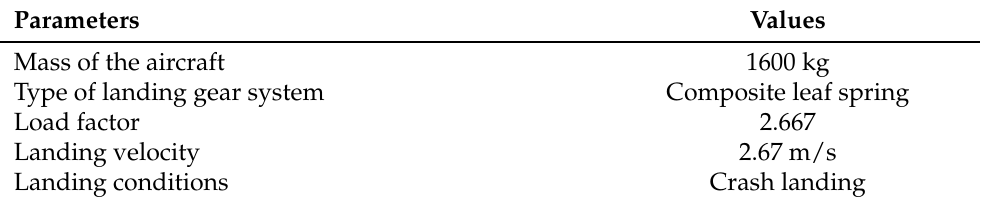
Table 1. Design constraints for the main landing gear struts of the given